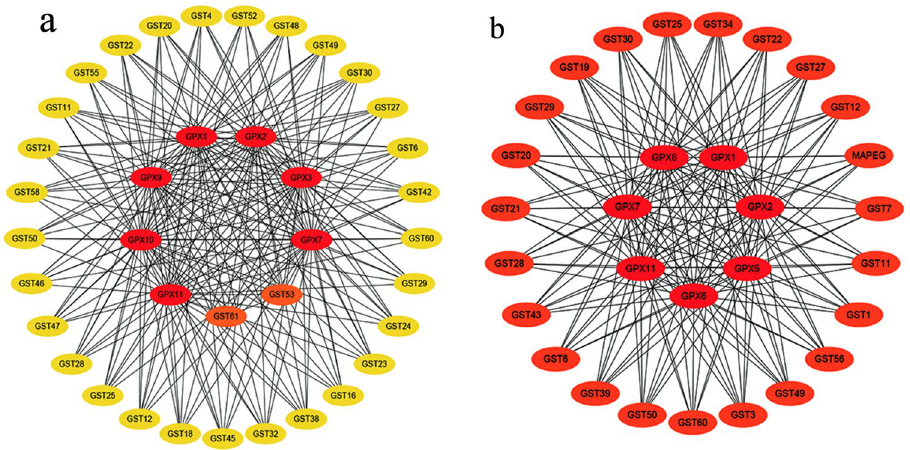
Figure 4. PPI mapping of DEGs in the glutathione-metabolism pathway. ( a ) Logarithmic phase. ( b ) Decline phase.